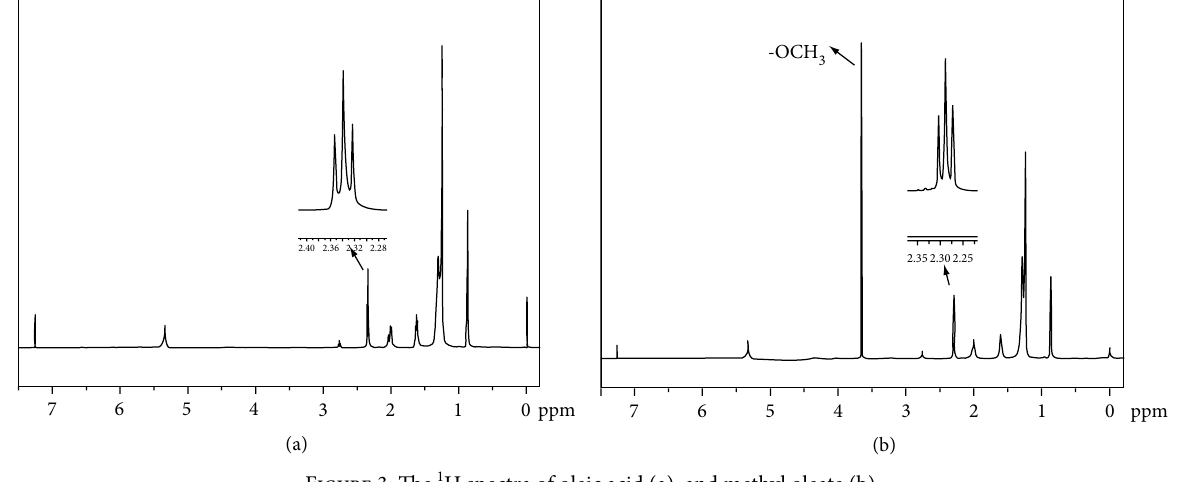
Figure 3: The 1 H spectra of oleic acid (a), and methyl oleate